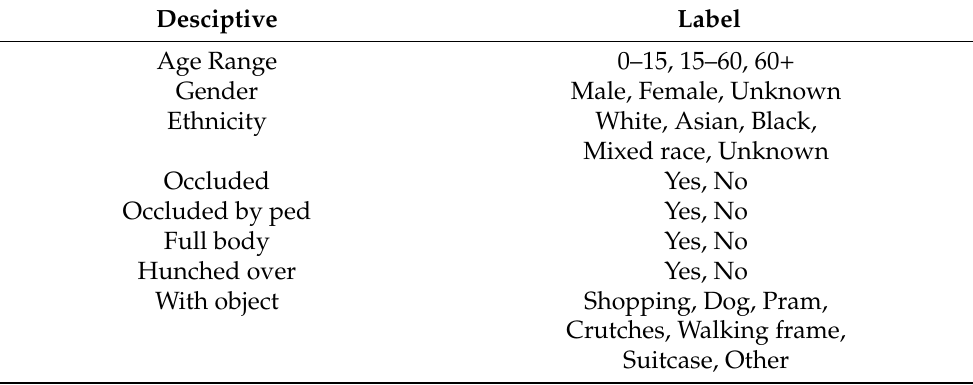
Table 5. Tertiary descriptive classes.